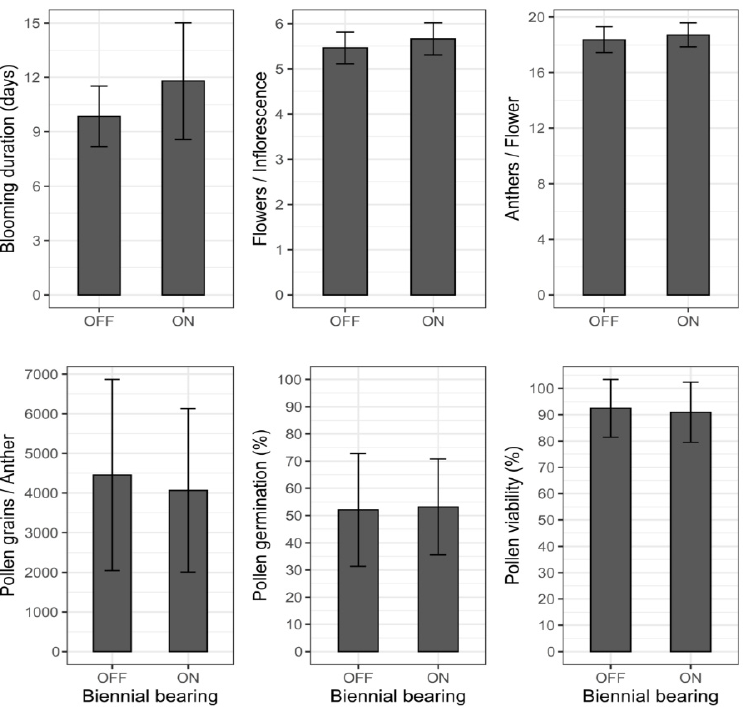
Figure 2. Effects of biennial bearing on floral and pollen biology attributes among a set of apple cultivars in Villaviciosa (north-western Spain). The biennial bearing effect is expressed as the difference in the mean values between the ‘on’ and ‘off’ years for six flowering-related traits. The vertical line shows the standard error of the